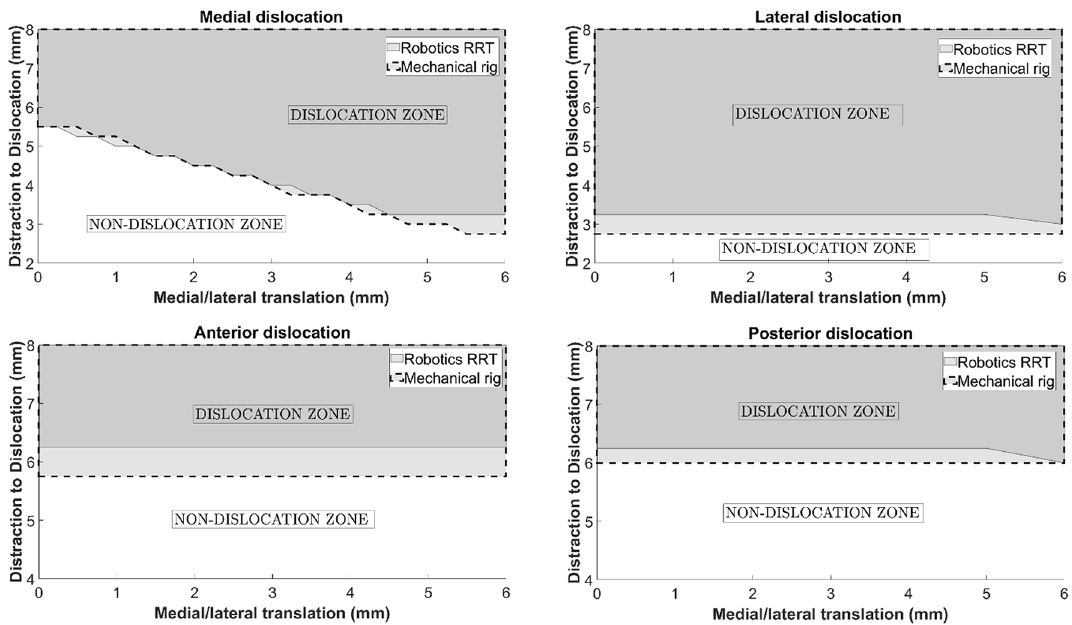
Figure 8. Mobile bearing dislocation (medially, laterally, anteriorly or posteriorly): the robotics dislocation analysis tool versus the mechanical rig. The grey region marks the dislocation zone while the white region marks the no dislocation